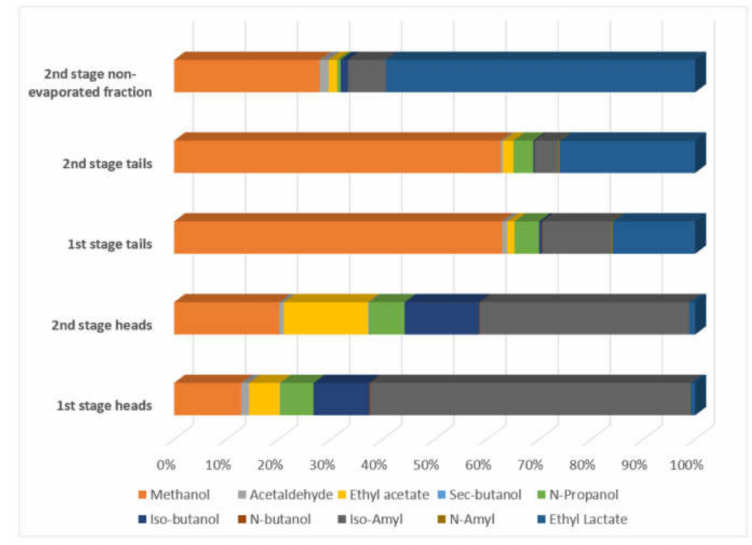
Figure 4. Chemical composition: mean mass proportion of minor components.